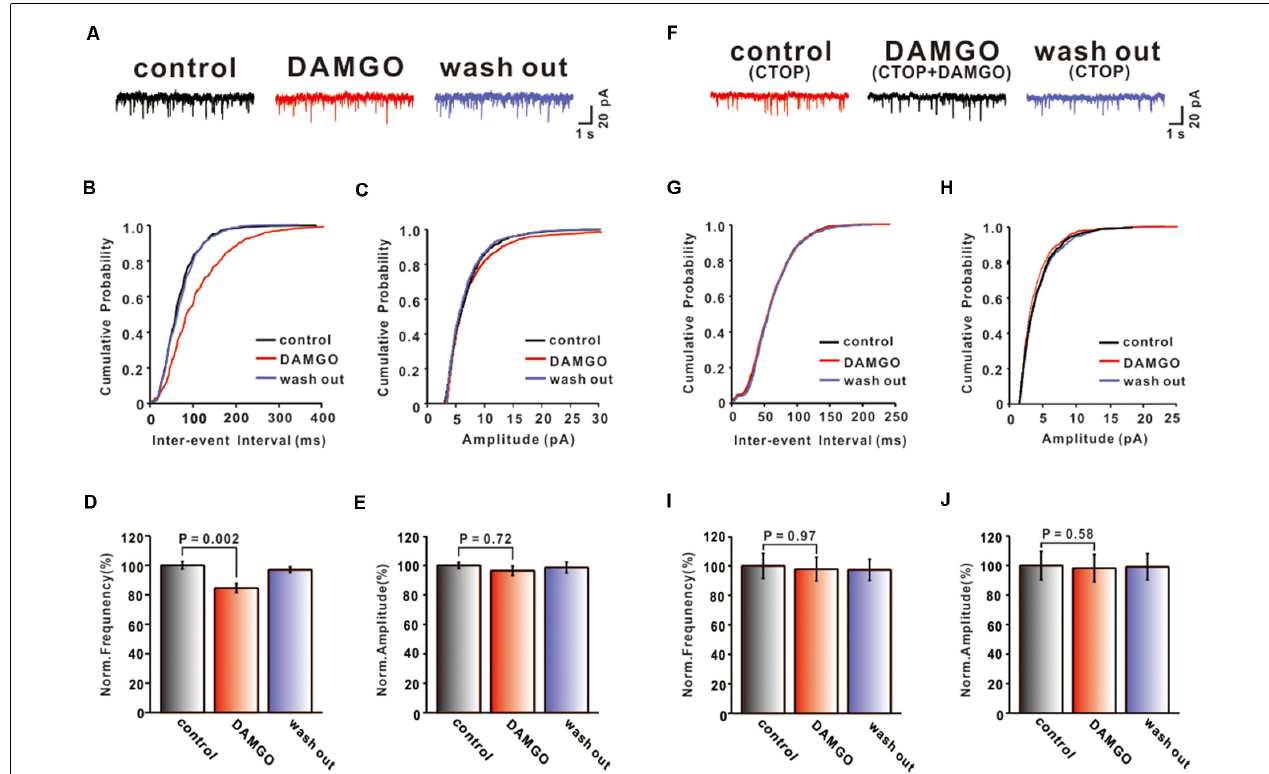
FIGURE 2 | Effects of MOR activation on PF-PC mEPSCs. (A) Representative traces of PF-PC mEPSCs in control, DAMGO (2 µ M), and washout conditions. (B,C) Cumulative probability plots of PF-PC mEPSCs frequency (interevent interval) (B) and amplitude (C) in control, DAMGO (2 µ M), and washout conditions. (D,E) Bar graphs showing the effects of DAMGO (2 µ M) on the PF-PC mEPSCs frequency (D) and amplitude (E) . (F) Represetative traces of PF-PC mEPSCs in control (1 µ M CTOP), DAMGO (2 µ M DAMGO + 1 µ M CTOP), and washout conditions. (G,H) Cumulative probability plots of PC mEPSCs frequency (interevent interval) (G)